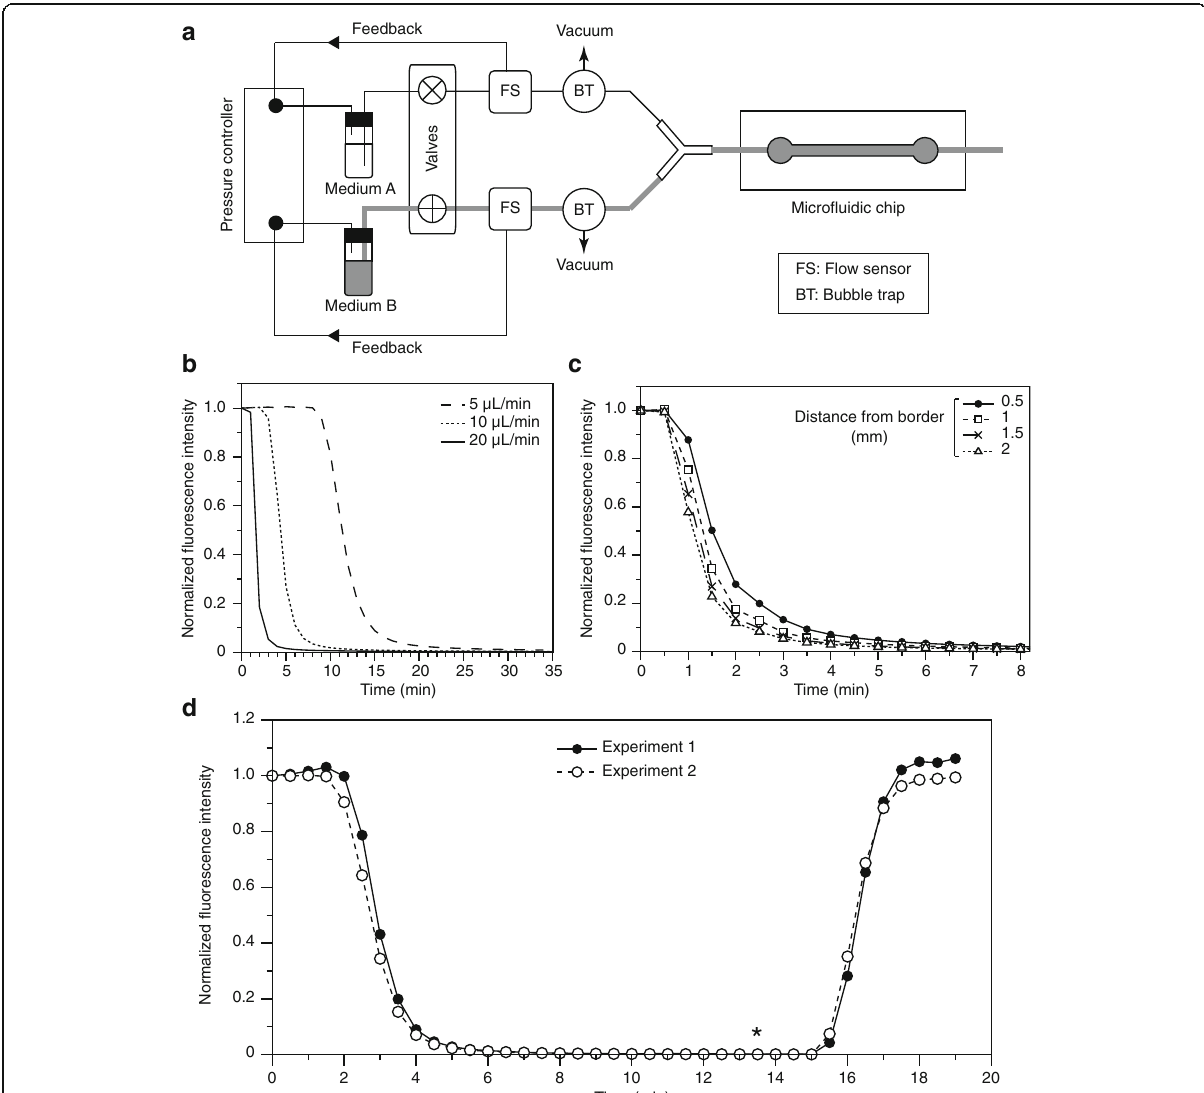
Fig. 3 Fast media switches using the elastomer microchips. a . Schematic of the setup used for switching media. Flow sensors (FS) modulate the operation of a pressure controller to maintain an accurate flow rate. Media switches are achieved using valves. Vacuum-based bubble traps (BT) limit the presence of bubbles (BTs were added when using cells but not in b - d ). b-d . All experiments used chips as in Additional file 4C. b. Media switch dynamics. 50 μ M Rhodamine B was perfused in the chip (20 μ L/min) for 10 min. Water was then injected (20 μ L/min, T = 0), and fluorescence intensity was followed over time. The chip was then re-used twice with the same protocol but with water perfusion at 10 μ L/min followed by 5 μ L/min. Data were corrected for the background (measured prior to the initial Rhodamine B injection) and normalized to T = 0 for each flow rate. c. Influence of the position within the channel on the media switch dynamics. 5 μ M Rhodamine B was injected (20 μ L/min) for 10 min prior to switching to water (20 μ L/min, T = 0). Fluorescence intensity was then measured over time at various distances from the channel border. Data were corrected for the background (measured prior to the initial Rhodamine B injection) and normalized to T = 0 for each position. d. Reproducibility of the media switch dynamics. 50 μ M Rhodamine B was injected (20 μ L/min) for 10 min. At T = 0 and T = 13.5 min (asterisk), the perfusion was switched to water (20 μ L/min) and back to Rhodamine B, respectively. Fluorescence intensity was then followed over time (Experiment 1). The same chip was re-used in an identical experiment (Experiment 2). Data were corrected for the background (measured prior to the initial Rhodamine B injection) and normalized to T = 0 for each